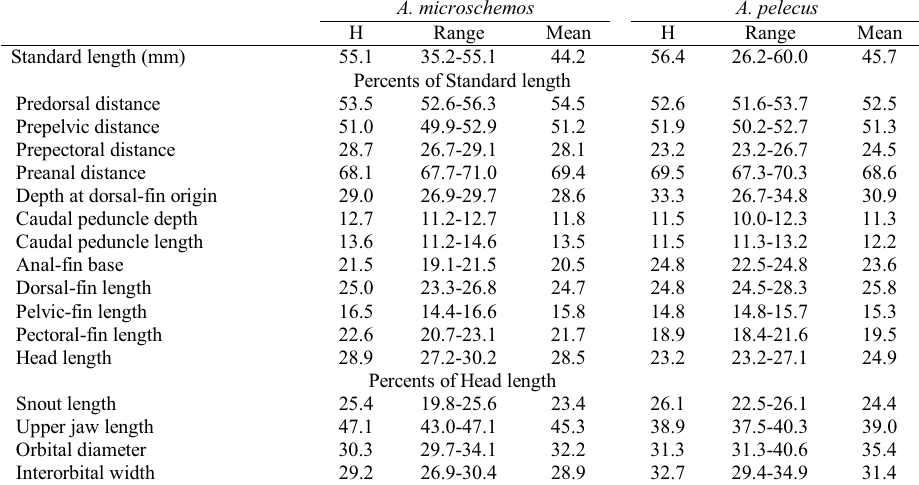
Table 1. Morphometric data of holotypes (H) and paratypes of Astyanax microschemos from the córrego Palmital, rio Itapemirim drainage, Espírito Santo (n = 20 including the holotype), and Astyanax pelecus from the rio Pardo drainage, Cândido Sales, Bahia (n = 9 including the